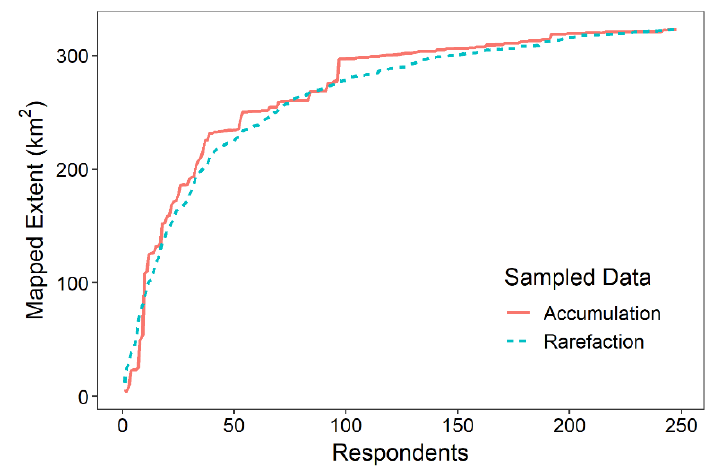
Figure 5. Two methods showed changes in the estimated extent of fishing grounds (in 2010) when di ff erent sample sizes of fishers were surveyed. The approach using an area accumulation curve represents one sequence for adding additional survey respondents. The approach using the area rarefaction curve was implemented through repeat resampling of respondents to create ten possible combinations of fishing grounds (ten for each number of respondents), and then plotting the mean estimated extent.